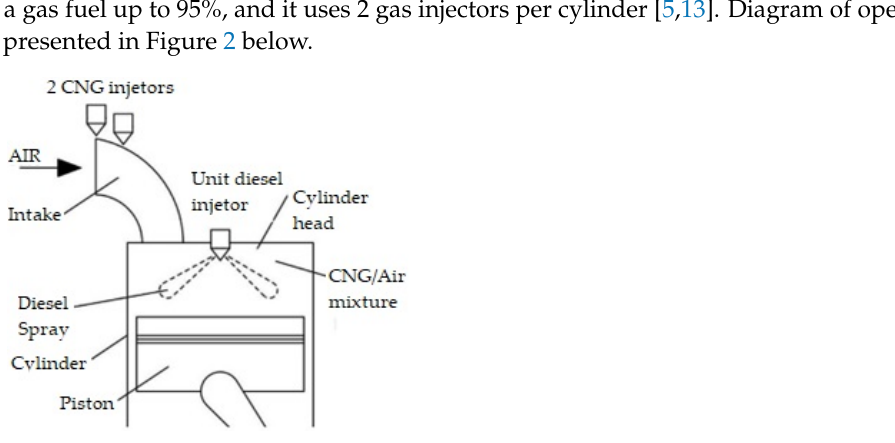
Figure 2. Diagram of operation of a dual-fuel supply system (authors’ source based on [14]). Table 3. Selected parameters characterizing the operation of the gas fuel supply system (manufac- turer’s data). Parameter